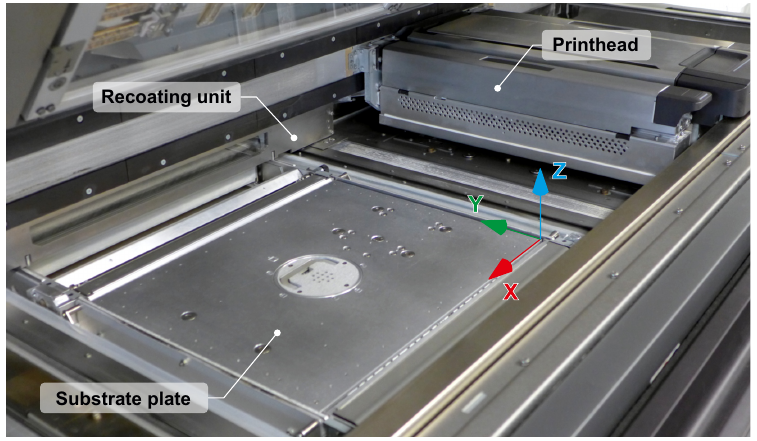
Figure 6. Coordinate system displayed in the build space of the HP machine. To distinguish all of the defined specimen orientations, a special marking system was used. The first part of the marking consisted of three digits, each of which may acquire a value of zero or one. These three digits mark the alignment of the specimen’s longitudinal axis with the X, Y and Z axes of machine’s build volume, respectively. The second part of the marking, separated from the first one by a hyphen, gives the angle value that defines the rotation of the specimen around its longitudinal axis. Within this part, 0°, 45° and 90° rotations were considered. This marking system is graphically expressed in Figure